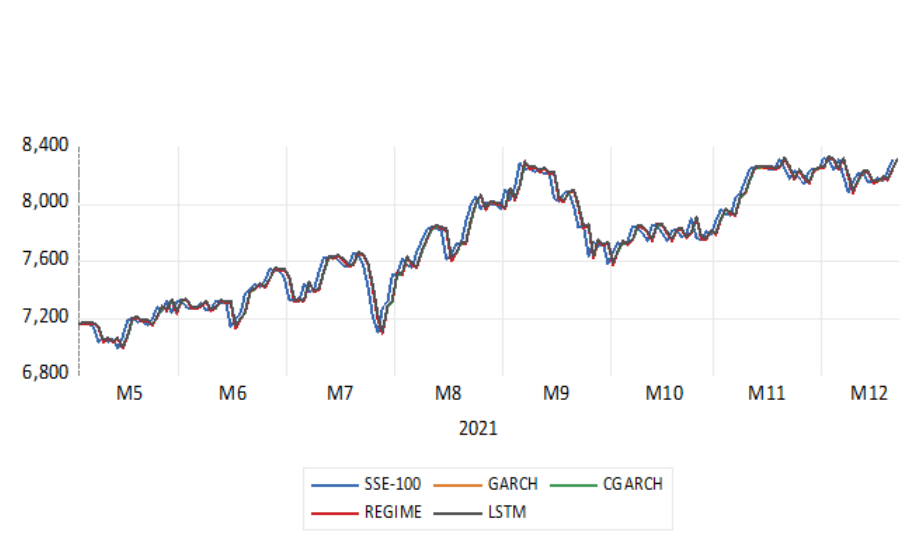
Figure A. 2: Forecast performance comparison